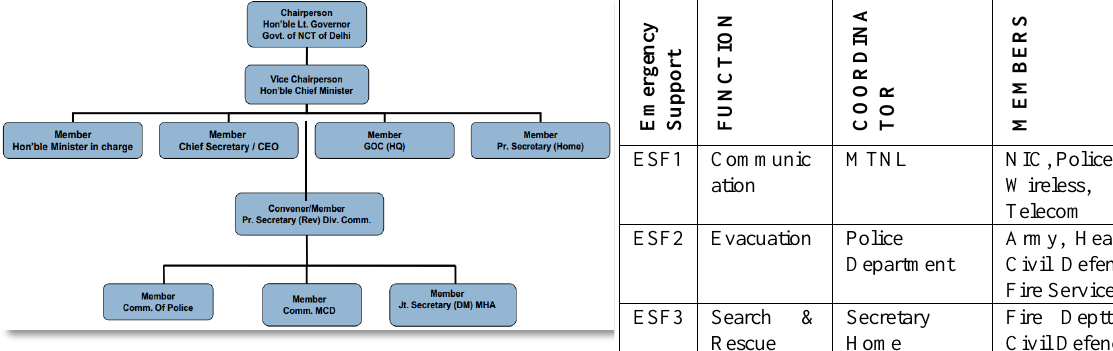
Figure 4a: Delhi Disaster Management Authority (Source: